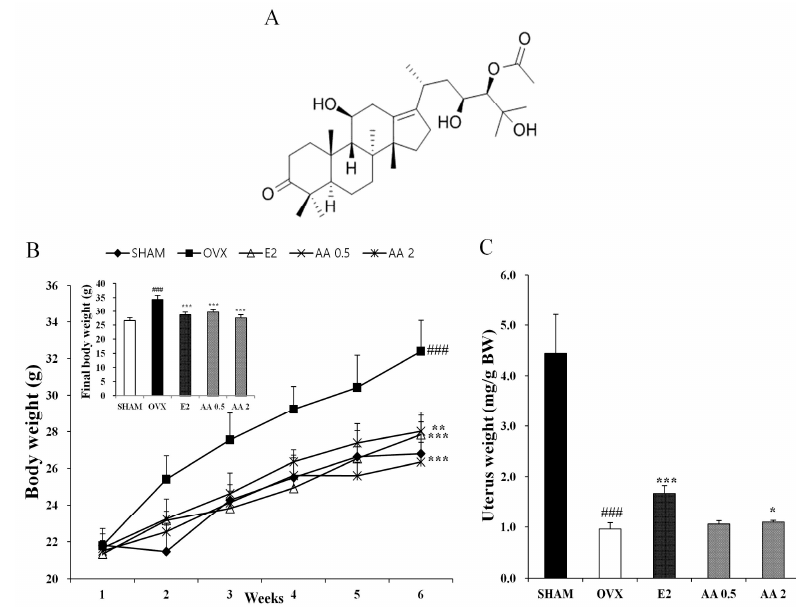
Figure 1. ( A ) Molecular structure of alisol A 24-acetate. Effect on ( B ) body weight and ( C ) uterine weight after six weeks treatment. Each value represents the mean ± SD for n = 5. ### p <